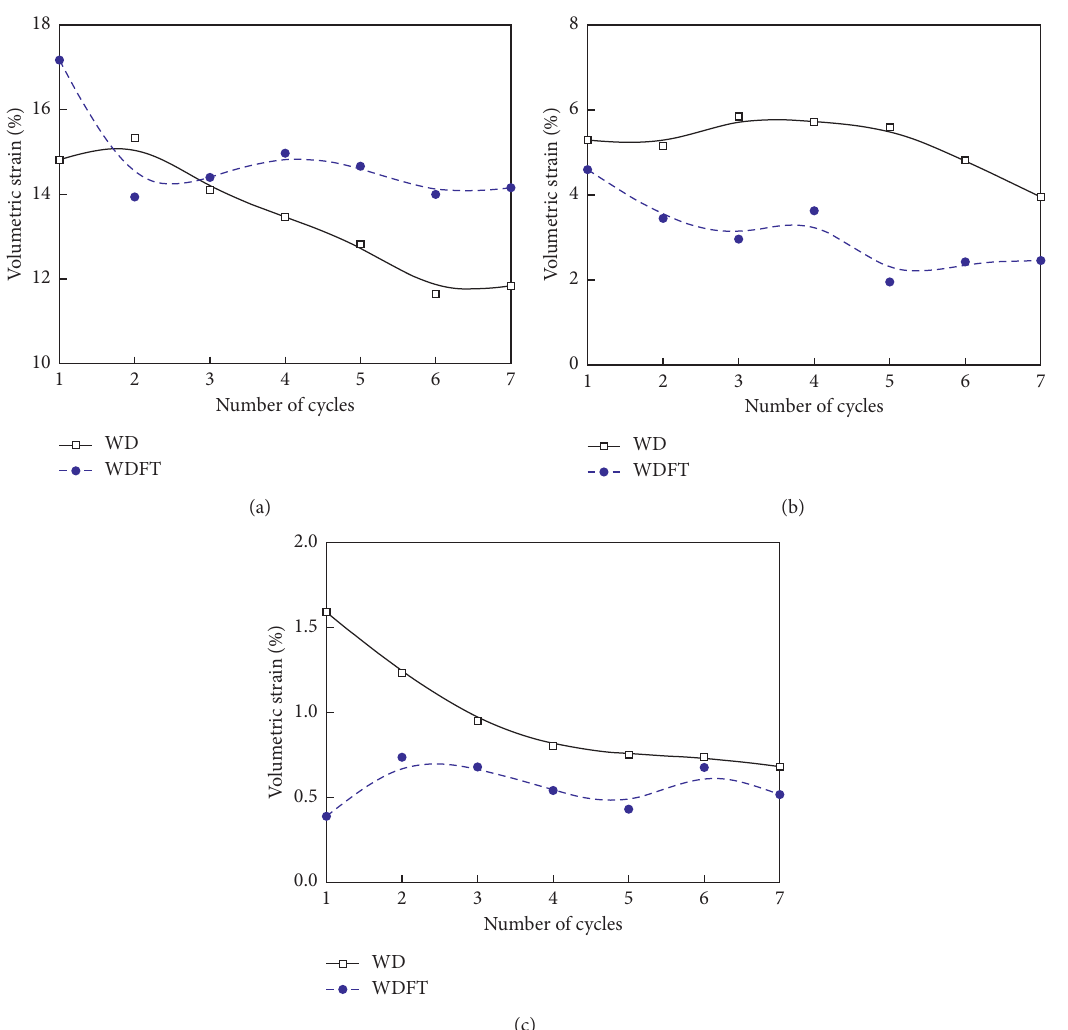
Figure 11: Comparison curves of volume changes under WD and WDFT cycles. (a) Dry range I. (b) Dry range II. (c) Dry range